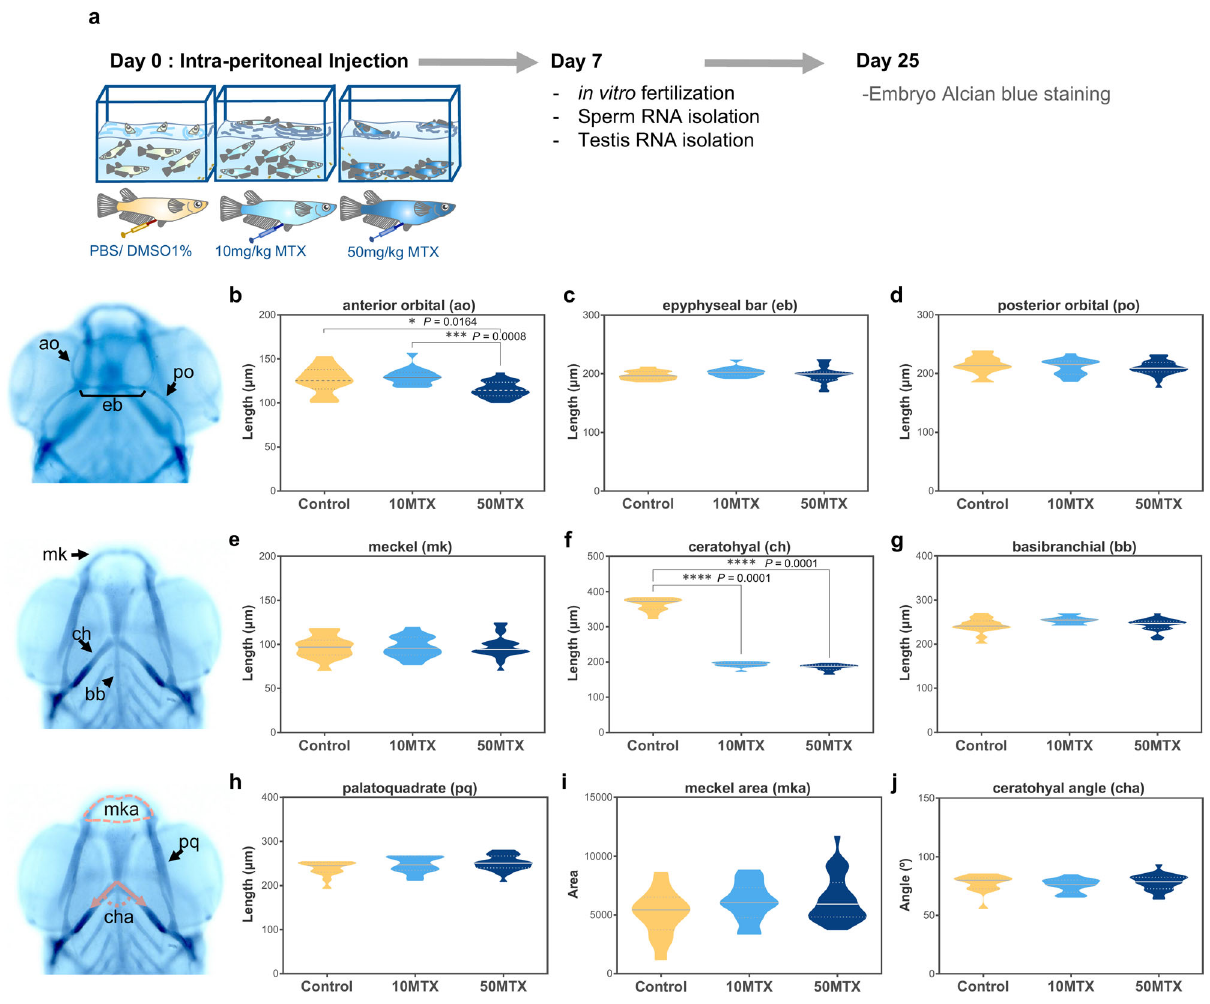
Fig. 1 | Paternal MTX injection affects offspring ’ s cranial cartilages lengths. a scheme of experimental design. b – j Violin plots represent the measurement of different cranial cartilages lengths, angles and areas on control (Ctrl), 10MTX and